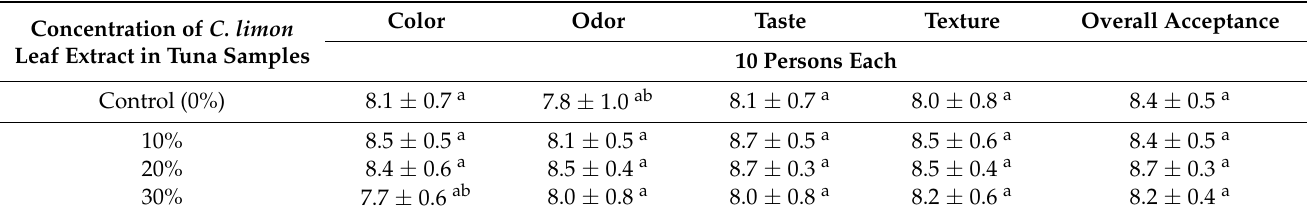
Table 10. Sensory evaluation of tuna quality for control and treatment with different concentrations (10%, 20%, and 30%) of C. limon leaf